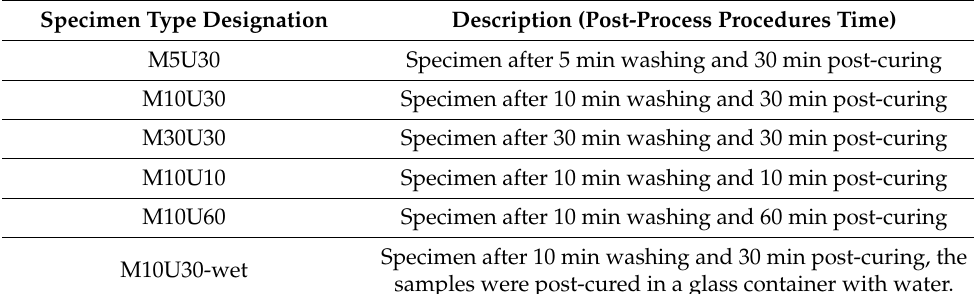
Table 1. Designations and descriptions of the samples used within the